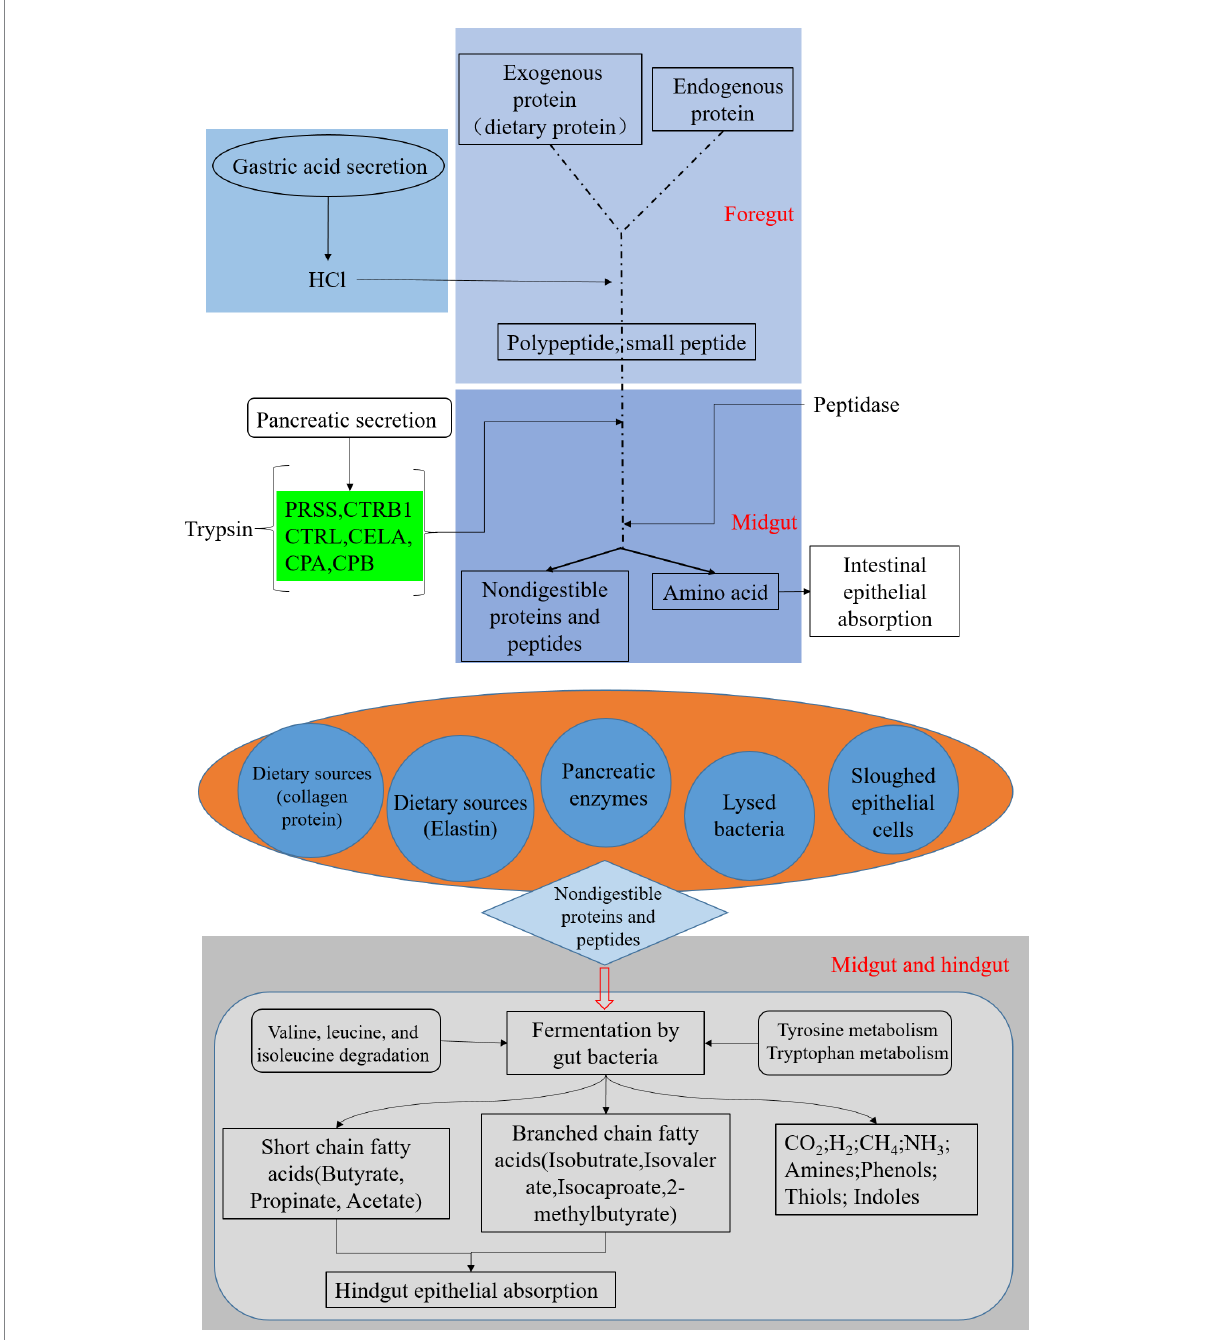
FIGURE 6 Black soldier fly genomic pathway annotation-protein digestion, reference to KEGG map04974, green boxes represent genes annotated on the